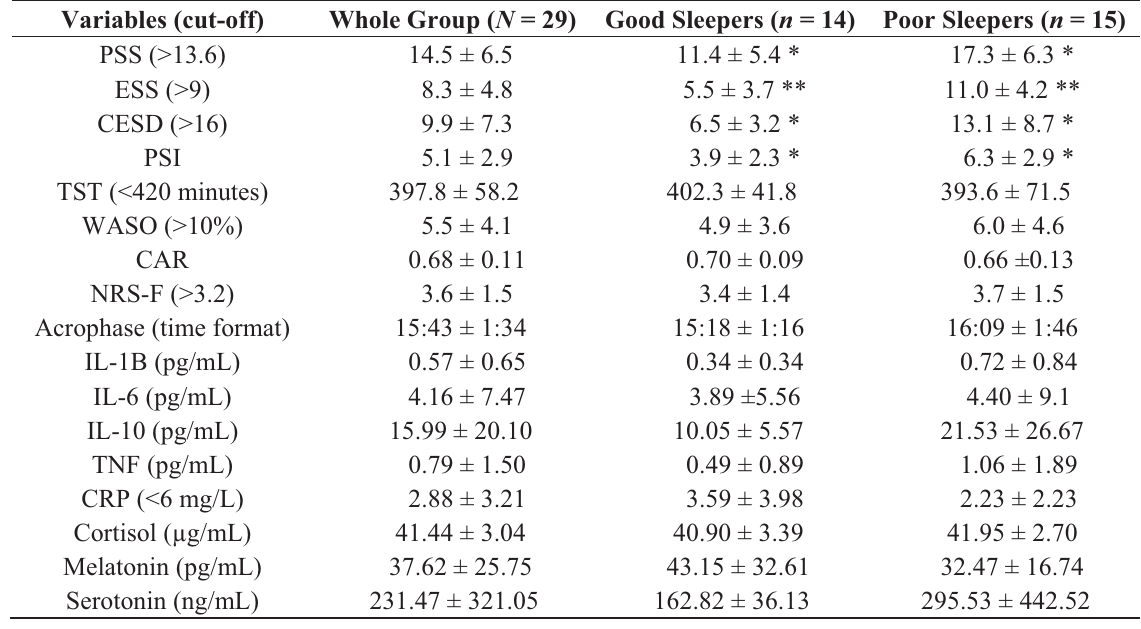
Table 3. Mean and standard deviation (mean ± SD) for the major